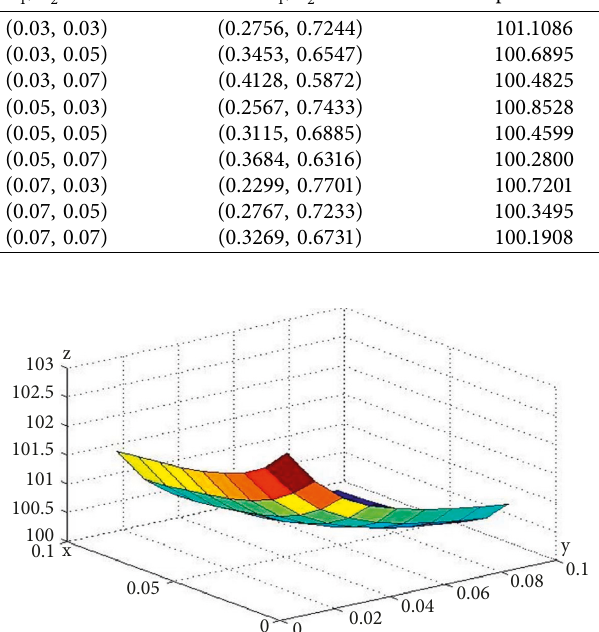
Table 4: The influences of E , E E 1 2